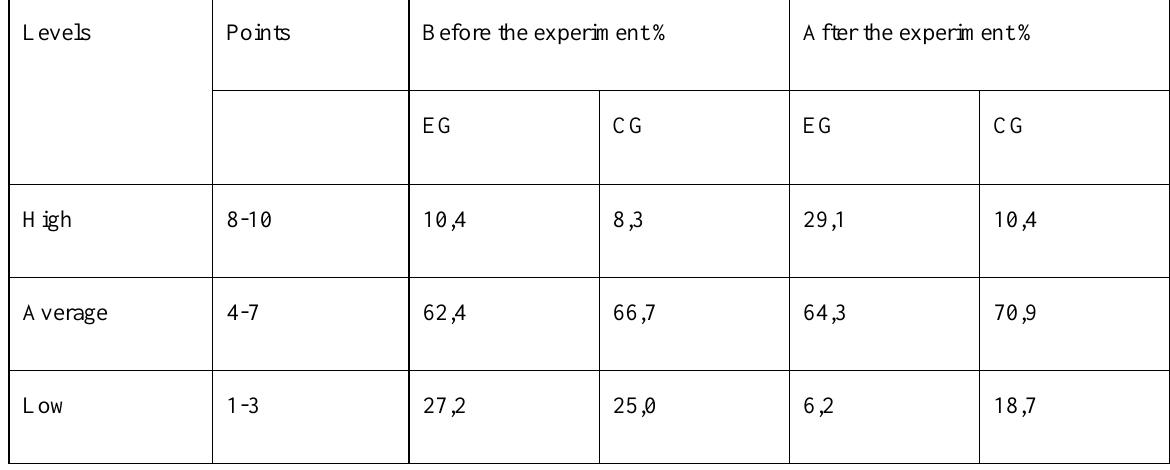
Levels Points Before the experiment % After the experiment %